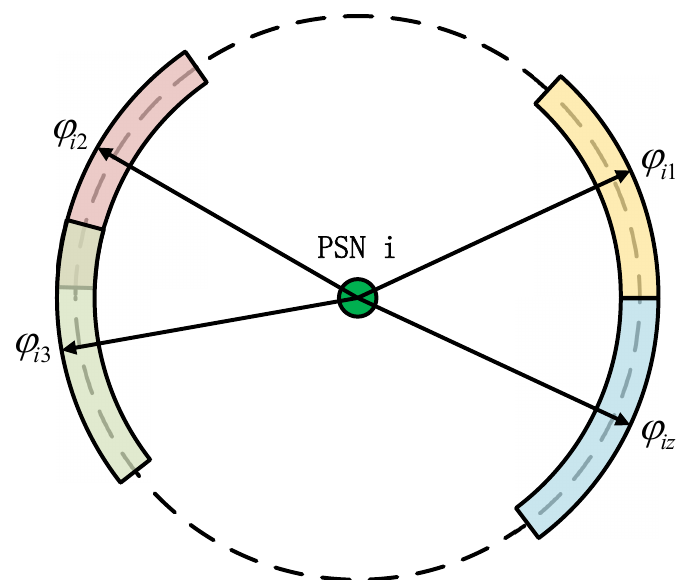
Figure 4. The azimuth distribution of the antenna on a power supply node